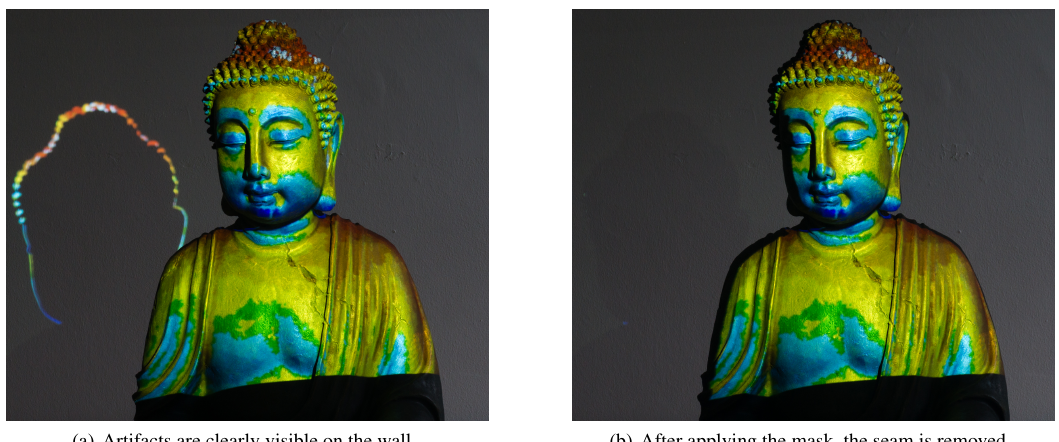
Figure 6. Due to the remaining errors of calibration and pose estimation of the projector-camera system, colored artifacts can be observed (left image). These artifacts can be removed through applying a depth buffer-based mask (right image). The lower part is black due to the restricted area that the projector can cover.